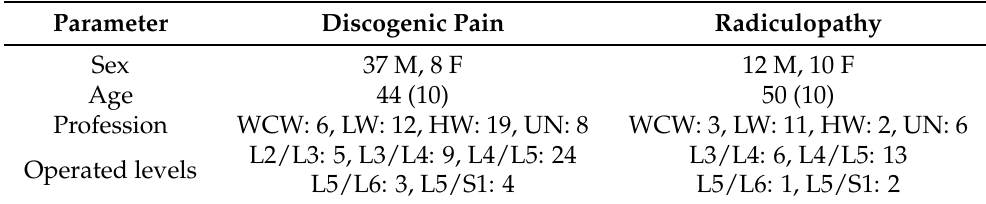
Table 1. Patient characteristics.